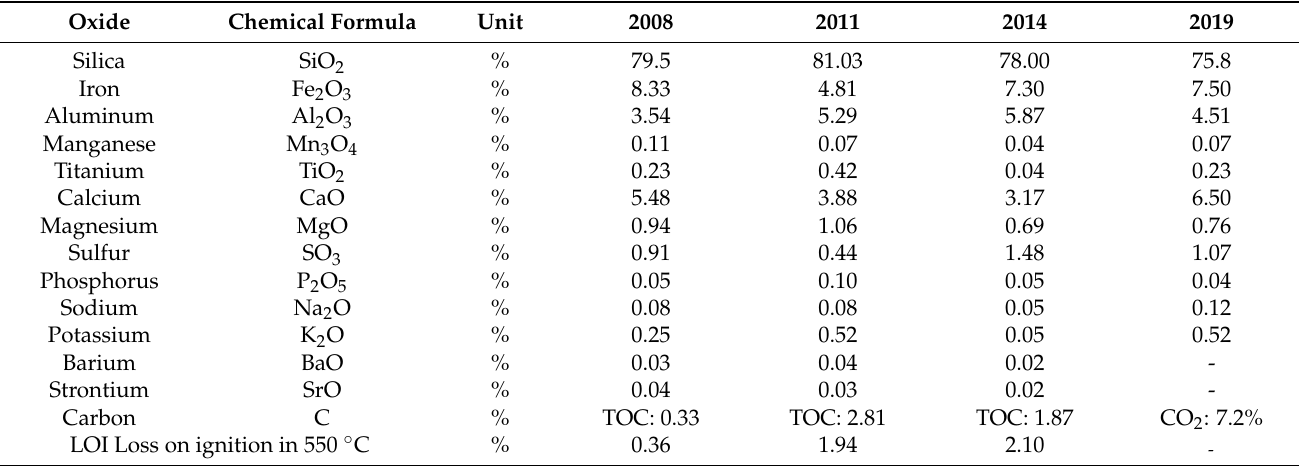
Table 2. The composition of furnace slag from lignite dust combustion, in the example years, in